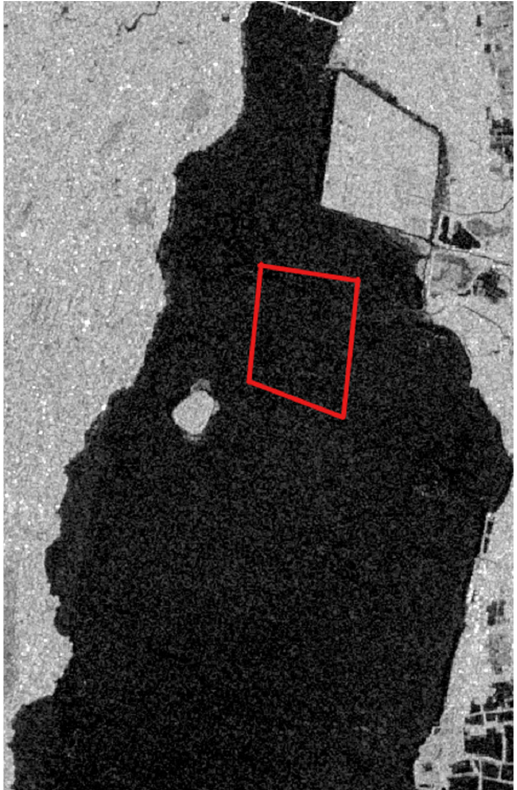
Figure 9. Mask of clean region within Vembanad Lake, 24 April 2020. The red polygon highlights the region used for the clean mask. (Sentinel-1, Credits: ESA).